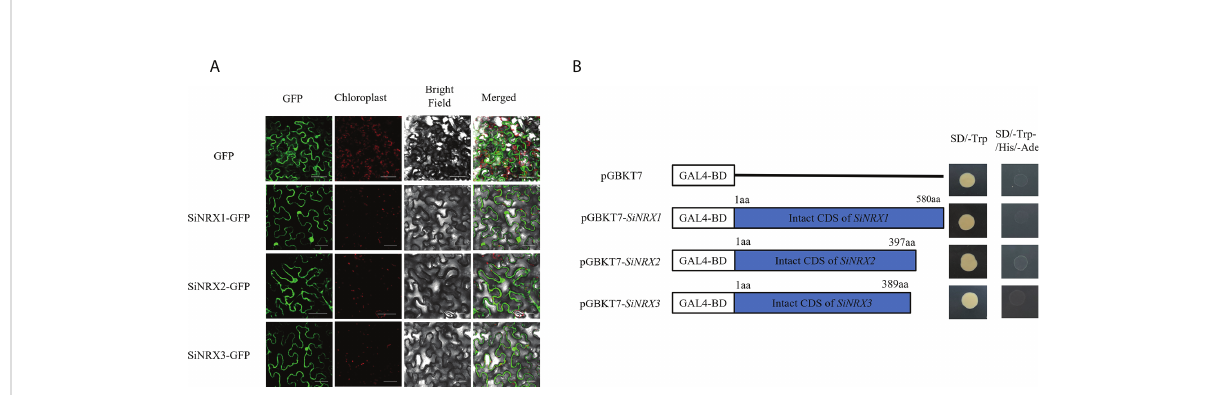
FIGURE 4 Subcellular localization and transcriptional activation of SiNRX1, SiNRX2 and SiNRX3. (A) Recombinant plasmid and control plasmid were transiently expressed in tobacco cells. The scale bar represents 50 m m. (B) The ORF fragments of SiNRX genes were ligated with pGBKT7 to construct a fusion vector. The yeast cells harboring SiNRX fusion vectors were cultured on the SD/-Trp and